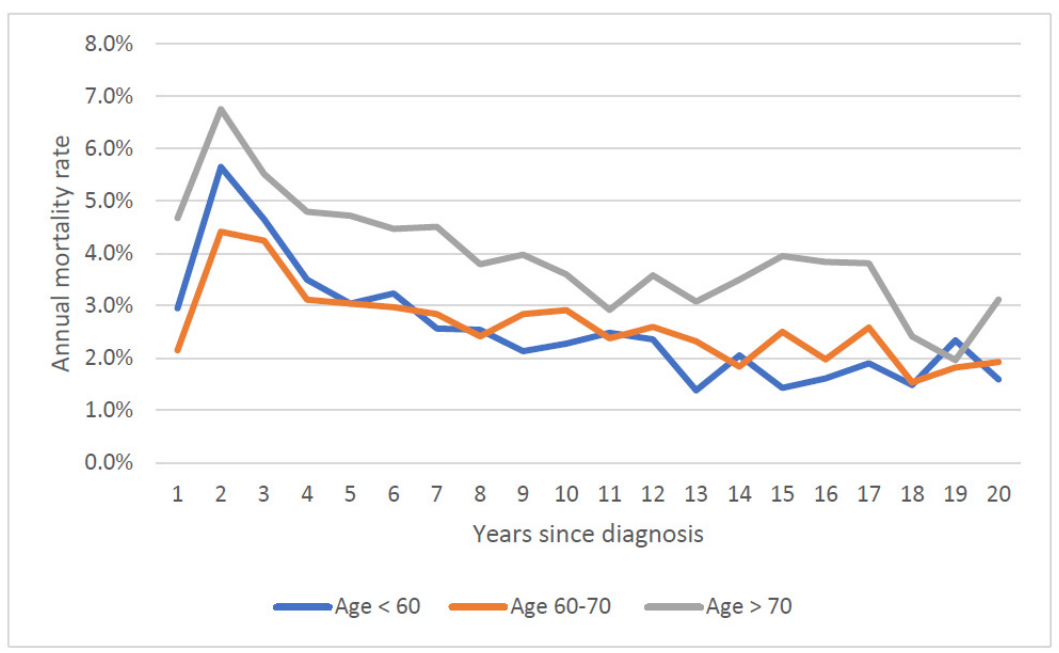
Figure 4. Annual prostate specific mortality rate by age of diagnosis (Gleason Score ≤ 7).